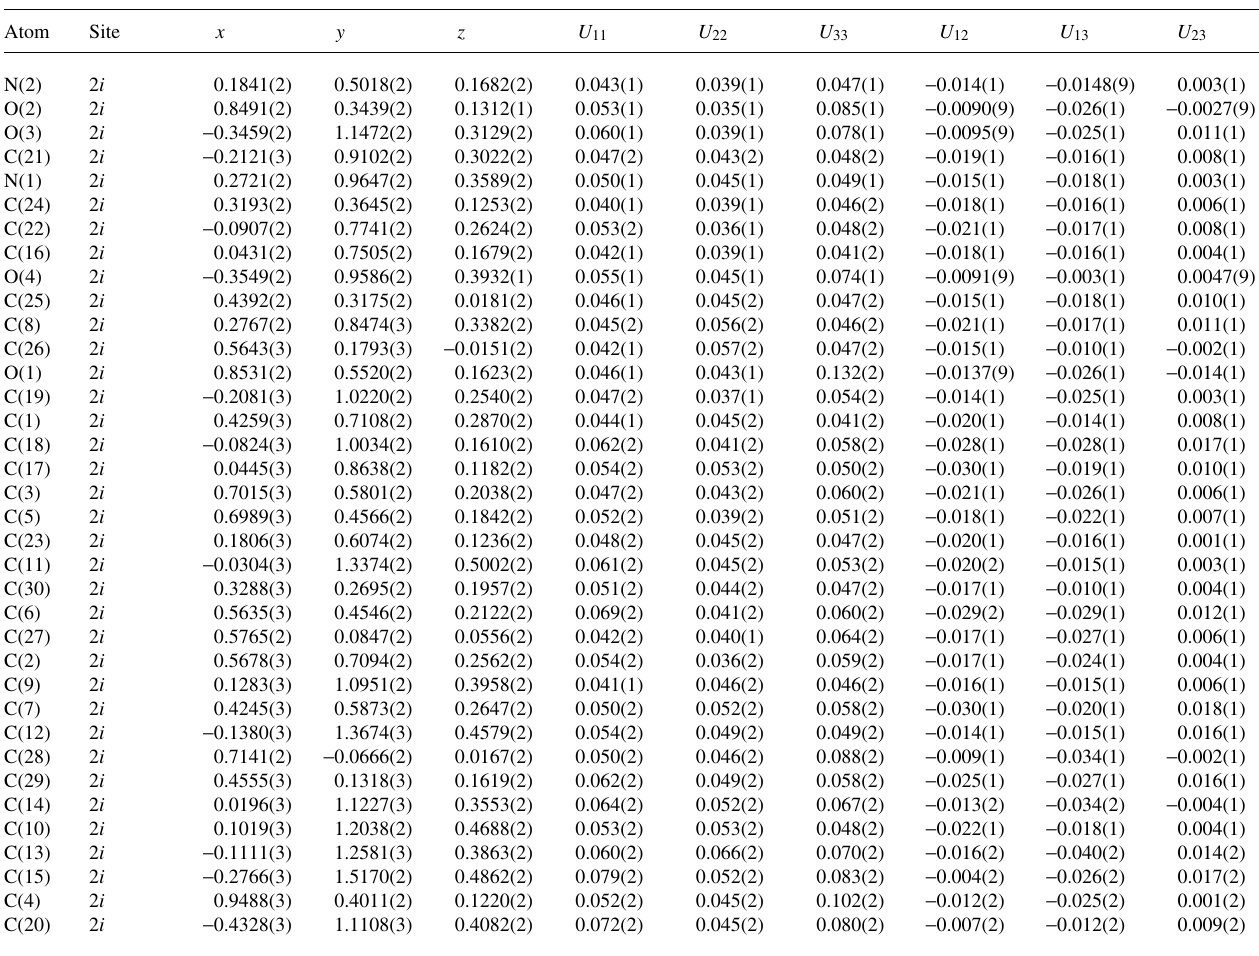
Table 3. Atomic coordinates and displacement parameters (in Å 2 )